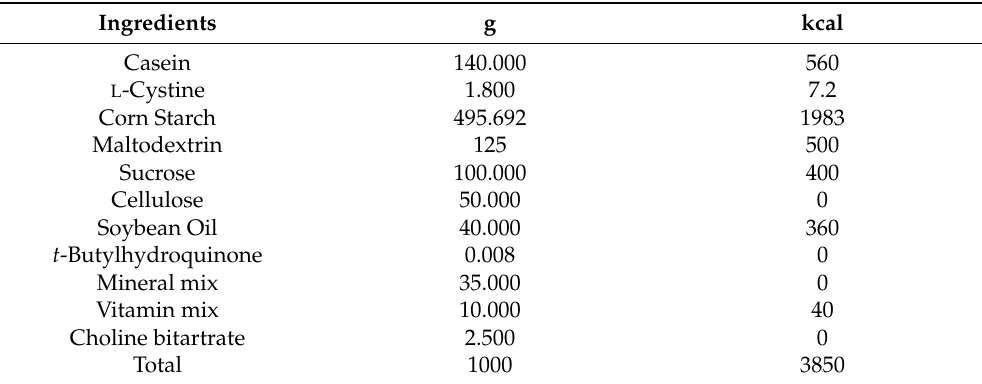
Figure 1. Schematic representation of the experimental program. Group C, Control; E, Exercise; E1, Exercise with 1 week to recover; ES, Exercise + Supplementation; ES1, Exercise + Supplementation with 1 week to recover. T, testosterone; W, weight; Hb, hemoglobin; BCAA, branched-chain amino acid; ROS, Reactive oxygen species; AP, antigen presentation. Table 1. Composition of the experimental diets * (g/kg).